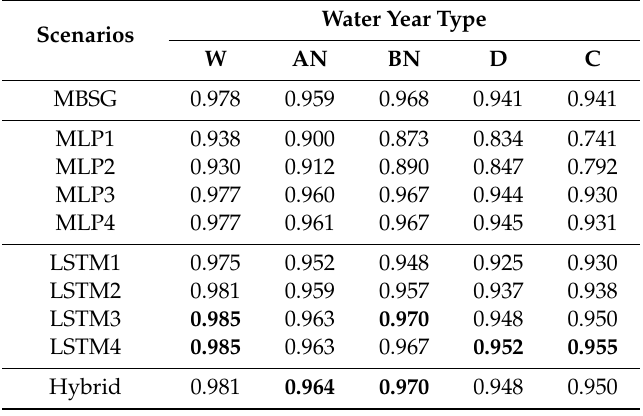
Table A4. Correlation between reference and simulated Martinez salinity in di ff erent types of water